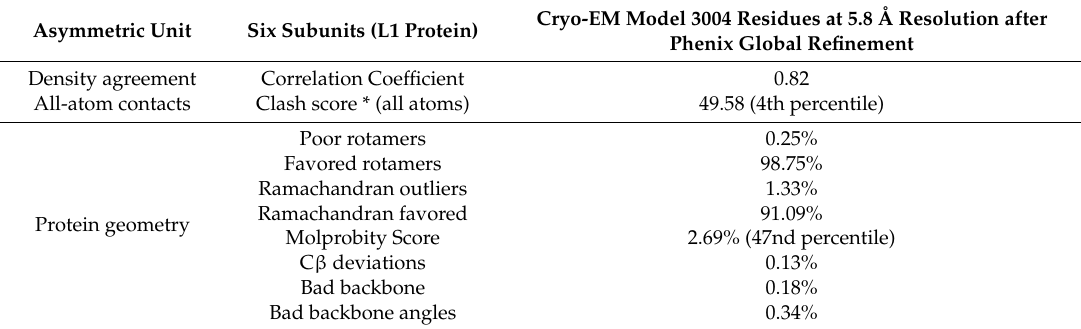
Table 3. Molprobity Statistics for